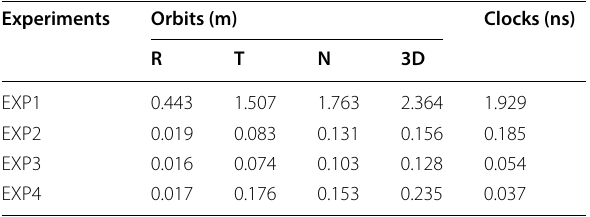
Table 2 Accuracies of orbits and clocks obtained by different OD and TS